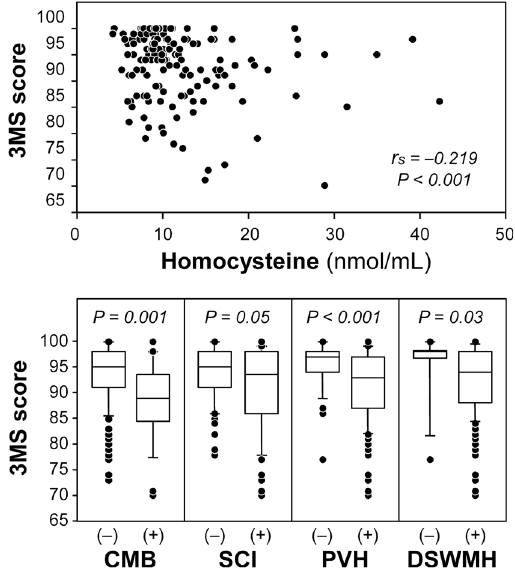
Figure 5. Unadjusted relationship of candidate mediators with 3 MS total score. Upper panel shows correlation between serum homocysteine concentration and 3 MS total score. Correlation was assessed by Spearman’s rank correlation test. Lower panels compare 3 MS total score between those with and without SVD. The box-and- whisker plots indicate 10th, 25th, 50th, 75th, and 90th percentile levels. Comparison between two groups was performed by Mann-Whitney U-test. Abbreviations are: SVD, small vessel disease; CMB, cerebral microbleed; SCI, silent cerebral infarction; PVH, periventricular hyperintensity; DSWMH, deep and subcortical white matter hyperintensity; eGFR, estimated glomerular filtration rate; r s , Spearman’s rank correlation coefficient; P, level of significance.